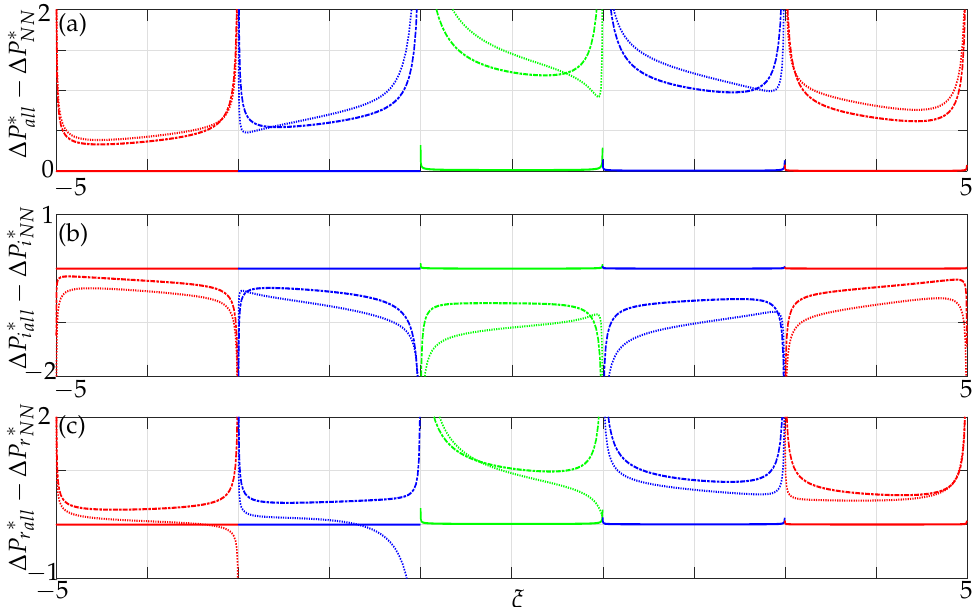
Figure 15. Difference in ( a ) absolute, ( b ) imaginary and ( c ) real values of nondimensional pressure difference across five beams incorporating all members and when only nearest neighbours are incorporated at Re = 1; solid lines: ¯ g = 8, dash-dotted lines: ¯ g = 0.4, dotted lines: ¯ g = 0.1, with the left-most beam active and the rest passive.